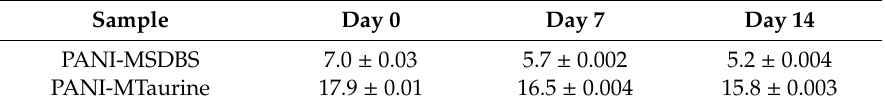
Table 2. The conductivity of bulk PANI (S cm − 1 ) containing the studied